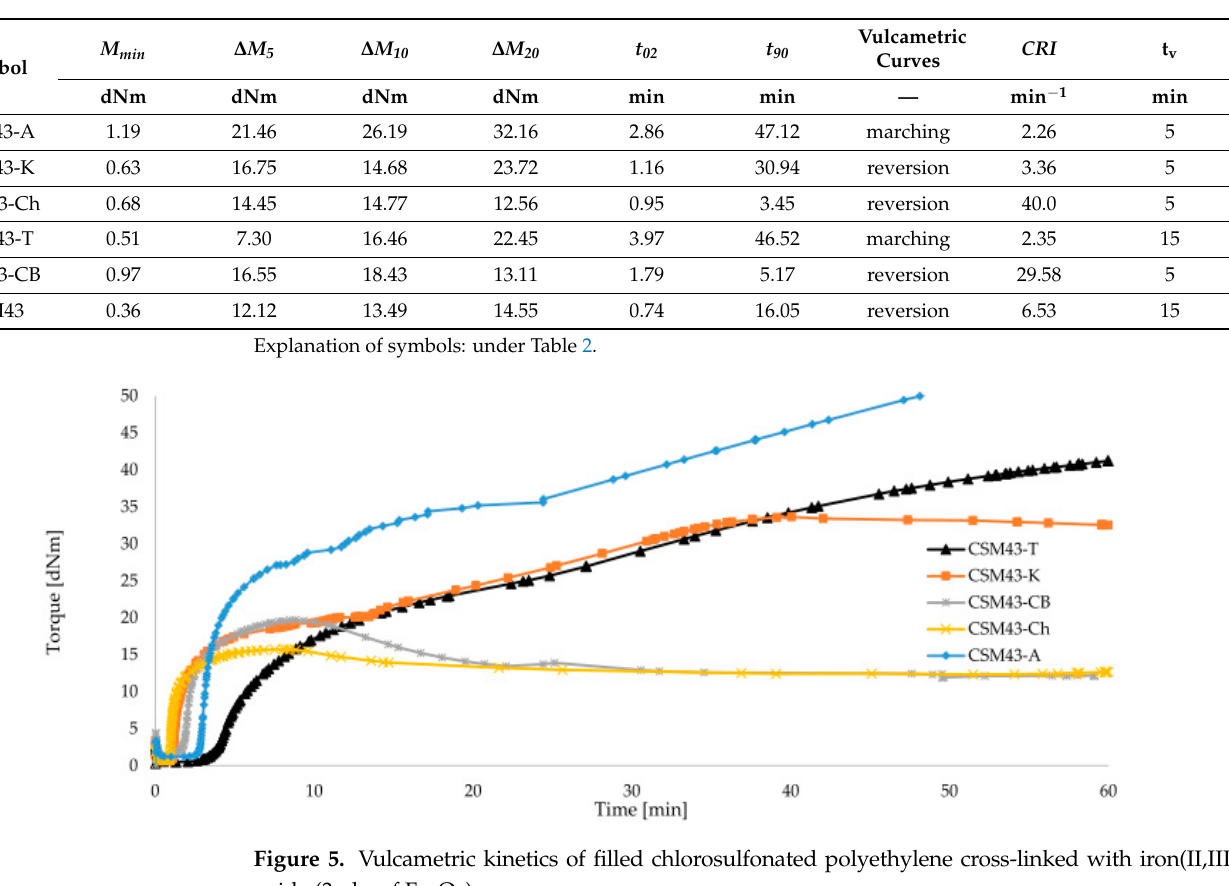
Table 7. Values of equilibrium swelling of filled CSM43 vulcanizates; T = 160 °C, t v = 5–15 min.